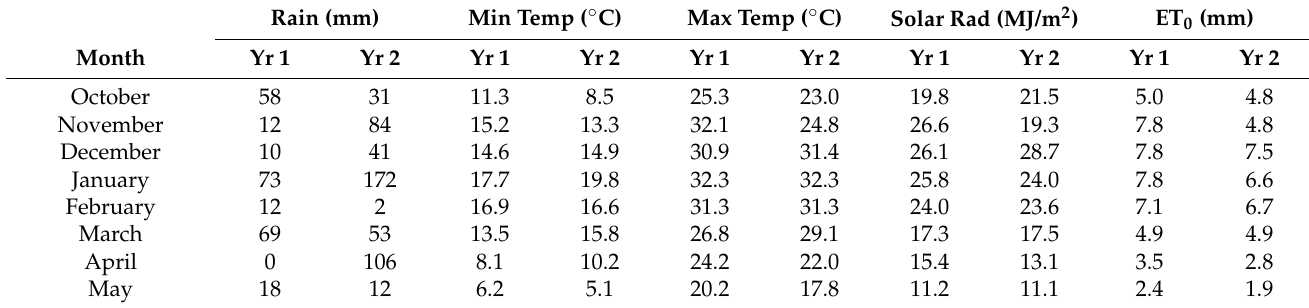
Table 2. Monthly rainfall and daily average values of minimum and maximum temperature, so- lar radiation, and ET 0 during the cropping seasons of 2020–2021 (Yr 1) and 2021–2022 (Yr 2) at Griffith, NSW